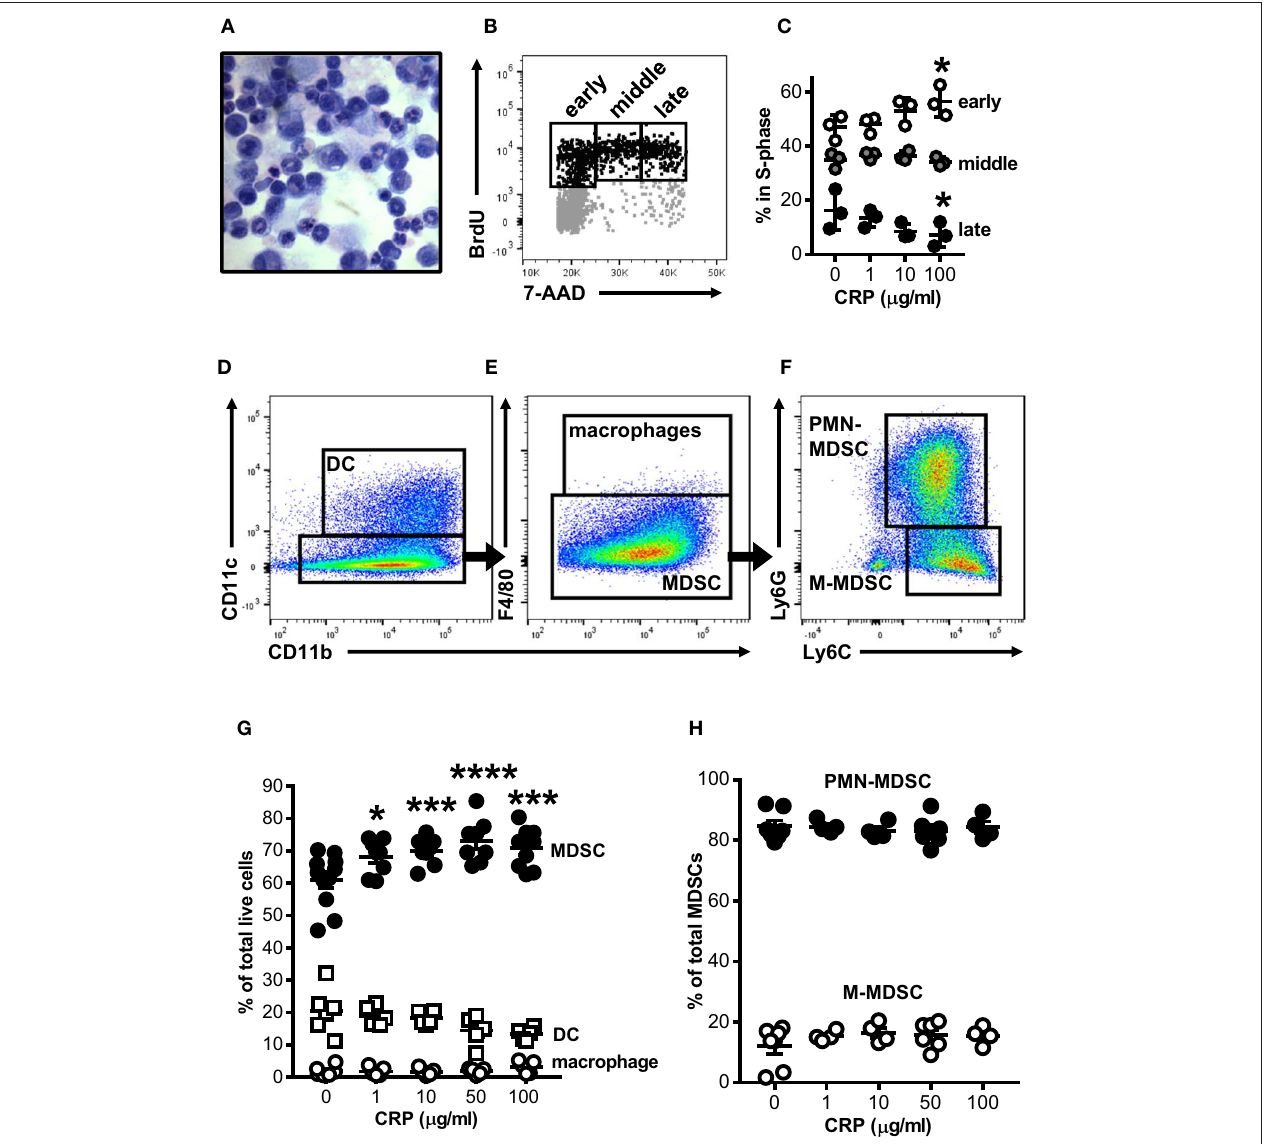
FIGURE 1 | Human CRP promotes expansion of mouse MDSCs. Mouse bone marrow progenitors cultured under conditions tailored to generate MDSCs (25) were used to study the effects of human CRP on MDSC expansion. After 4 days in culture (d4) the majority of cells retained their immature nuclear morphologies ( A ; light micrograph showing Wright-Giemsa and hematoxylin stained cytospin; 100X) and 25 ± 2.1% were in the S-phase of cell division ( B ; representative flow cytometry dot plot showing the gating strategy used to identify cells in the early, middle, and late stages of S-phase; see the Materials and Methods for details). Addition of human CRP to the cultures dose-dependently increased the entry of cells into early S-phase (C) ; the asterisks indicate p < 0.05 for Dunnett’s tests comparing cultures receiving 100 µ g/ml CRP and those left untreated. The representative data shown is the mean ± SD for technical triplicates (1 of 3 biological replicates). (D–F) Flow cytometry gating strategy used for identification of CD11c + CD11b + DCs (D) , CD11b + CD11c − F4/80 + macrophages (E) , and CD11c − CD11b + F4/80 − Ly6G + Ly6C + MDSCs (E) ; MDSCs were further divided into PMN-MDSC (CD11b + CD11c − F4/80 − Ly6G + Ly6C + ) or